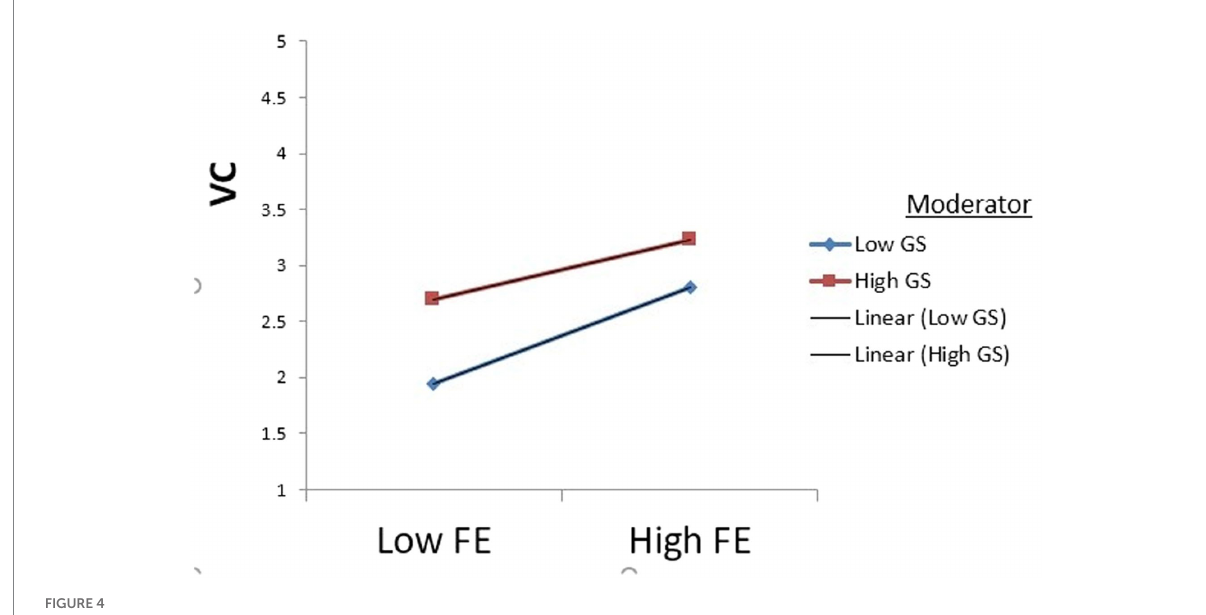
FIGURE 4 Moderation